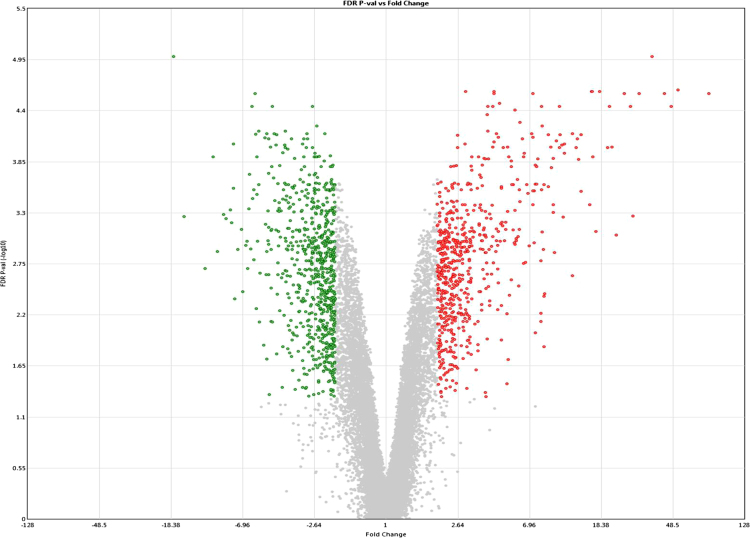
Volcano plot visualization of differentially expressed genes.